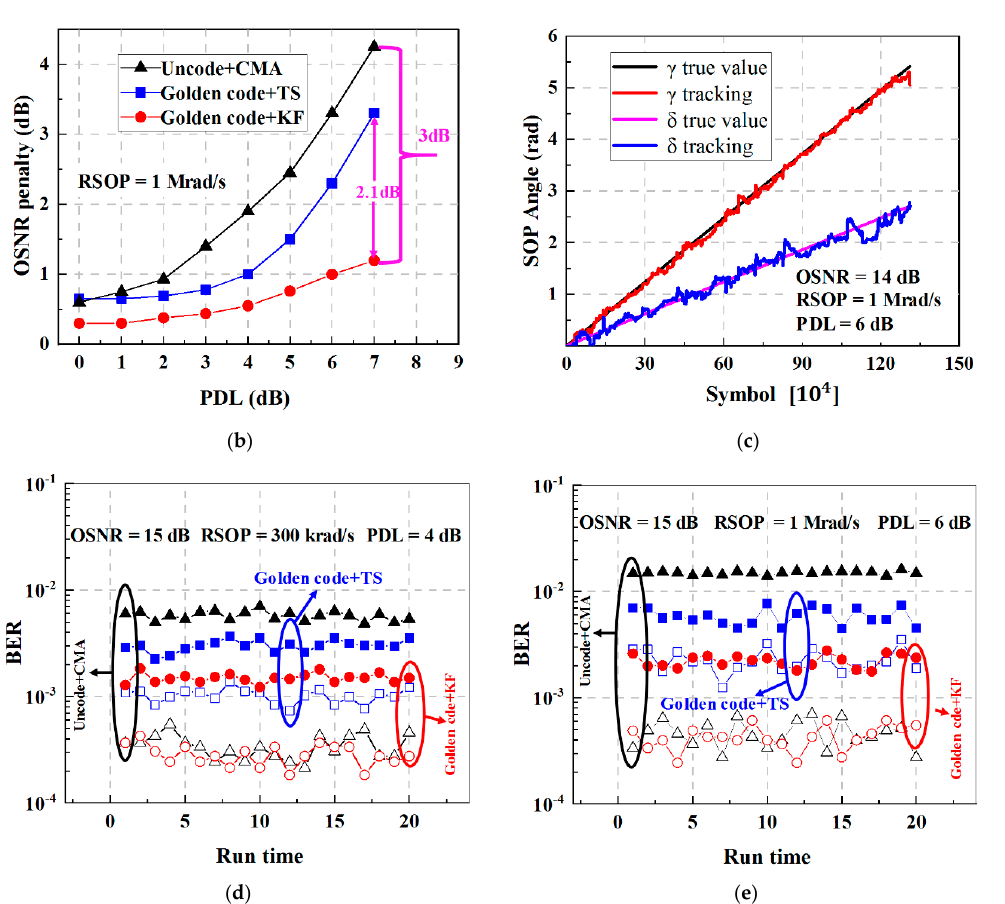
Figure 7. The performance comparison: ( a ) BER vs. OSNR; ( b ) OSNR penalty vs. PDL; ( c ) RSOP tracing curve; ( d ) BER performance under weak impairment condition; ( e ) BER performance under severe impairment condition.